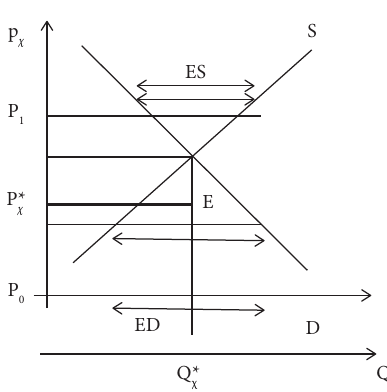
Figure 2: Te supply curve.